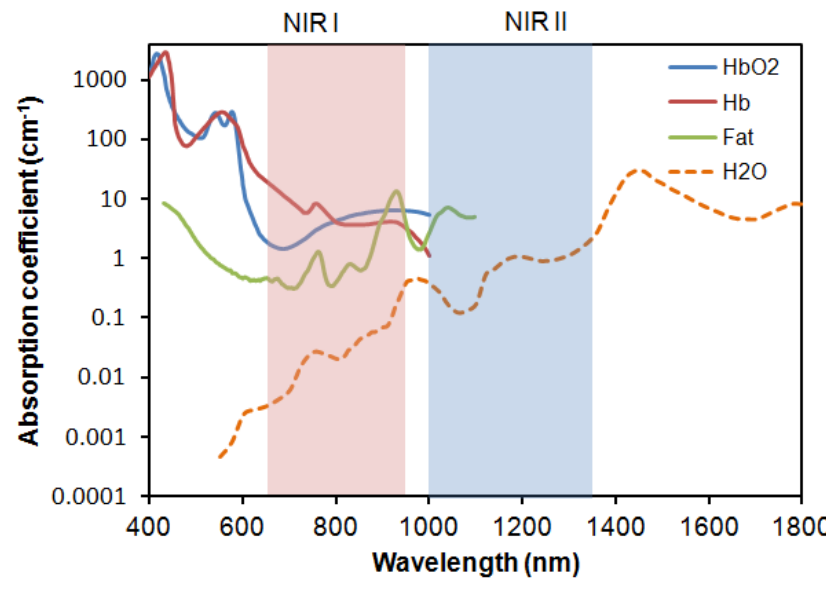
Figure 2. Absorption coefficient (on a log scale) of oxygenated blood, deoxygenated blood, fatty tissue and water as a function of